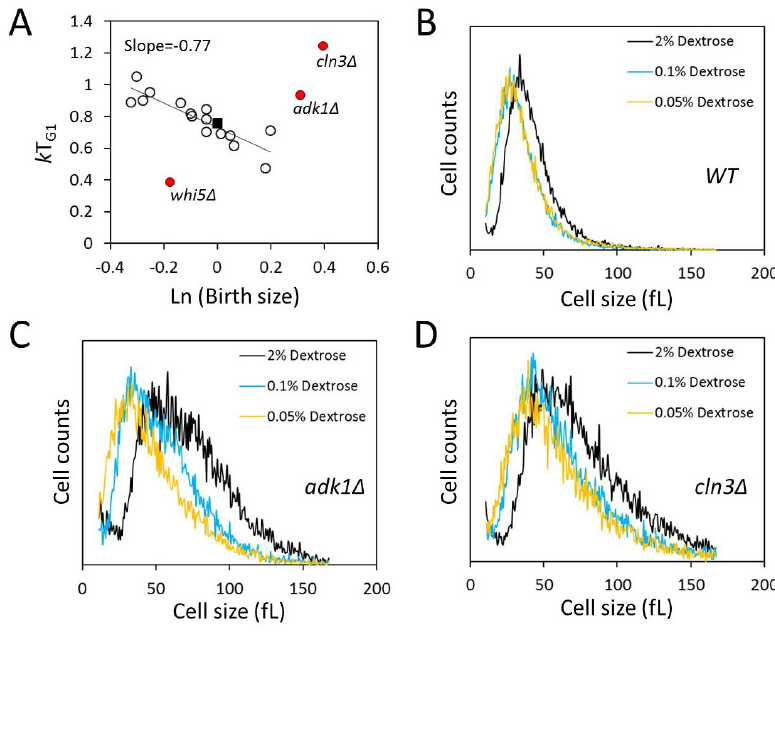
FIGURE 4: Adenylate kinase has a role in the efficiency of size control, but cells lack- ing Adk1p still adjust their size in response to nutrients. (A) In most mutants we exam- ined (shown with open circles) size control operates efficiently. The filled square is the wild type value. On the x-axis is the natural logarithm of the normalized birth size values used in Fig. 3 (with the wild type values equal to one), which were obtained from the data in Table 2. These were plotted against their relative growth in size during the G1 phase ( k T G1 , y-axis). The values we used were the average from the two strain backgrounds. The line is a linear fit obtained with the regression function of Microsoft Excel, from all the strains except those shown in red. (B-D) Cell size histograms of exponentially and asynchronously proliferat- ing wild type haploid cells of the indicated genotype (all in the Y7092 background) cultured in 1% w / v yeast extract, 2% w / v pep- tone and the indicated amount of the car- bon source shown. The x-axis is cell size and the y-axis is the number of